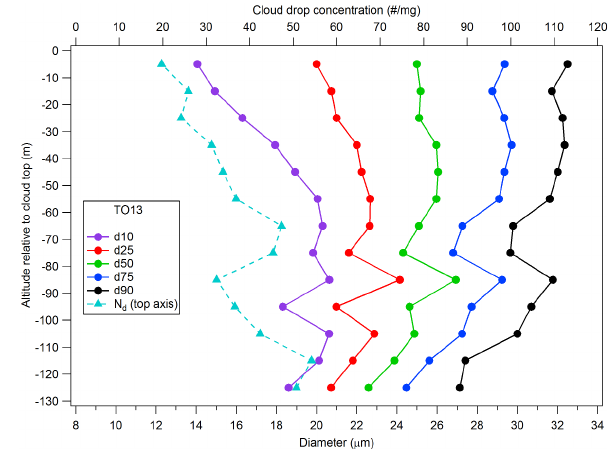
Fig. 10. Vertical profiles of droplet number concentration (triangles, blue, upper axis) and percentiles of droplet size distribution (circles) as a function of altitude relative to cloud top (binned to 10 intervals). Measurements from the phase-Doppler interferometer during TO10.